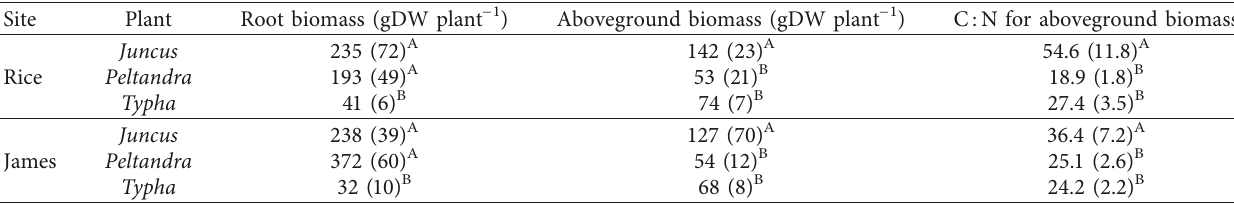
Figure 3: Plant-effect ratio for (a) bacterial and (b) denitrifier abundance associated with either the rhizosphere ( X -axis) or rhizoplane ( Y - axis) samples collected in June. The solid lines represent the 1:1 relationship wherein the rhizosphere and rhizoplane effects are equal. Table 2: Plant characteristics for June sampling reported as mean and standard